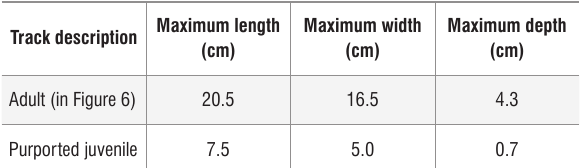
Selected track dimensions